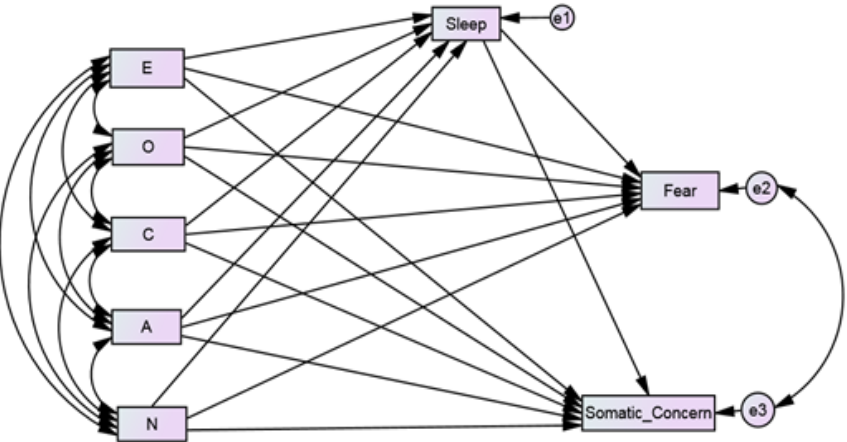
Figure 1. Conceptual model showing the relationship between the big five personality traits (E = Extraversion, O: Openness, C: Conscientiousness, A: Agreeableness, N: Neuroticism) and COVID-19 anxiety components (Fear and Somatic Concern) mediated through sleep quality.